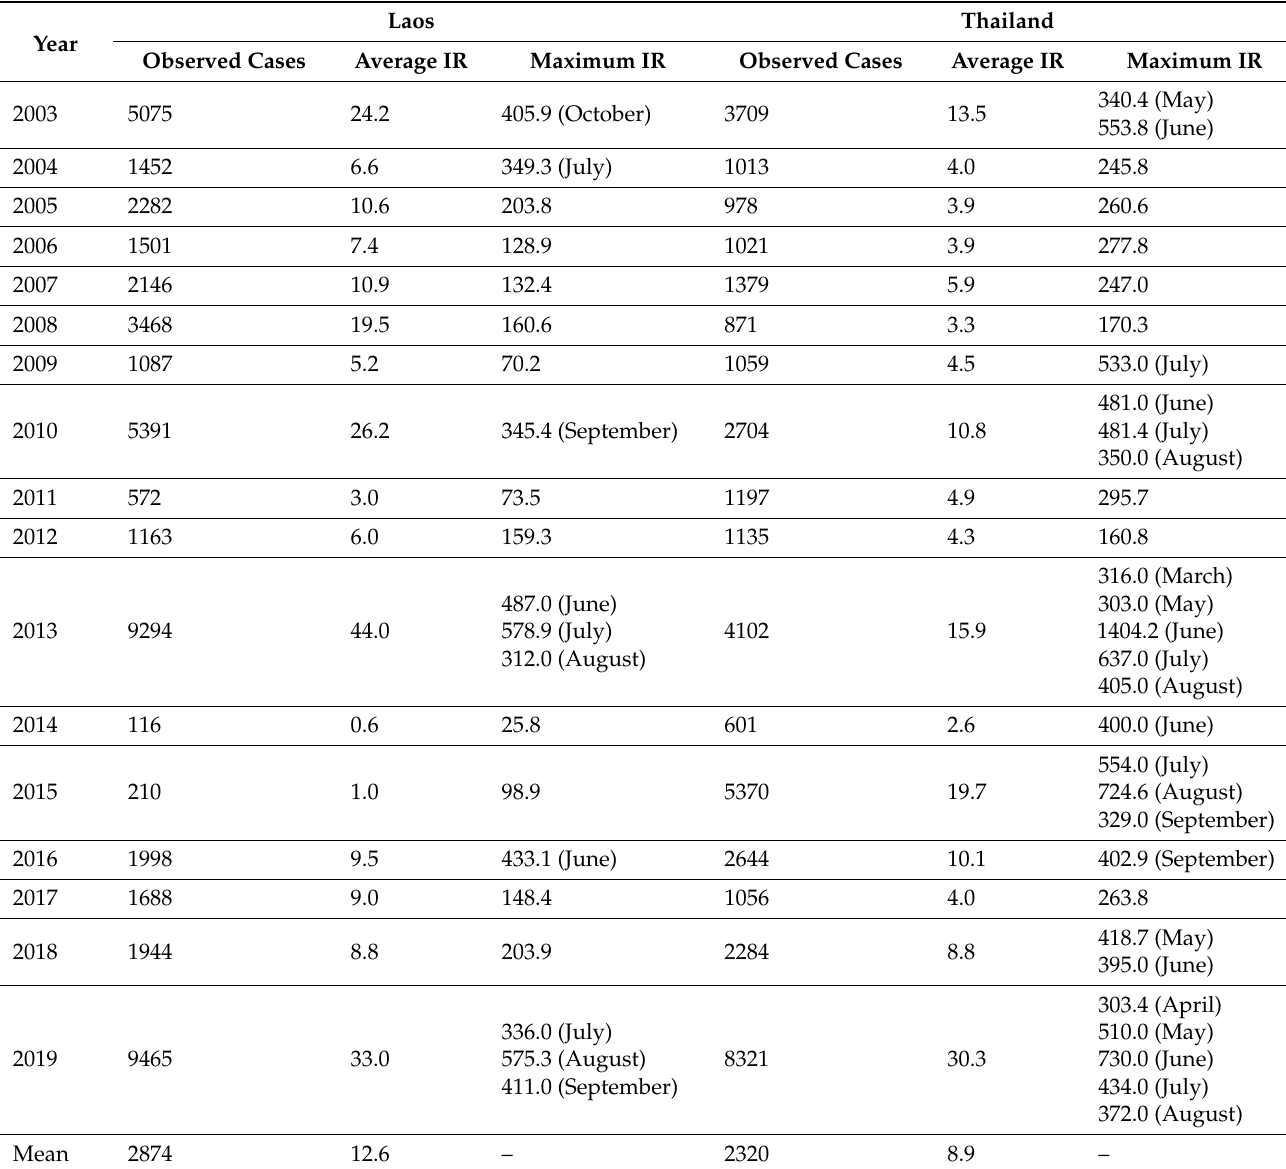
Table 4. Number of reported dengue cases and mean incidence rate (IR) and maximum incidence rate (IR) in two selected provinces in Laos and Thailand during 2003–2019. Outbreak years are those when maximum incidence rates exceeded 300 per 100,000 population in any month in any district. Months of highest IR are indicated in